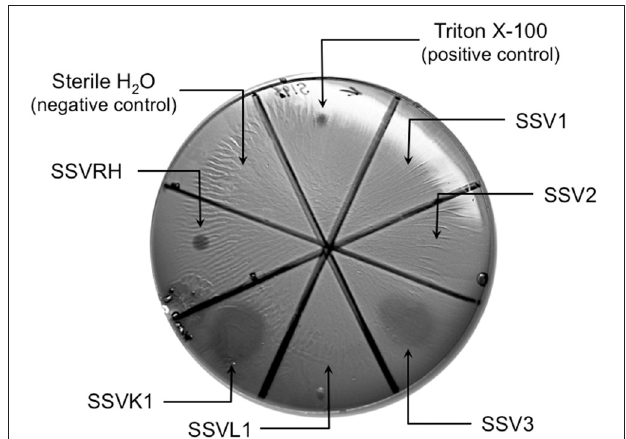
FIGURE 4 | Sulphurisphaera ohwakuensis is susceptible to SSV infection. Virus infectivity was assessed as in Figures 2 and 3 . SSV3, SSVRH, and SSVK1 produce halos on Sulphurisphaera ohwakuensis , a Japanese isolate, closely related to Sulfolobus tokodaii . SSV1, SSV2, and SSVL1 did not inhibit growth of this